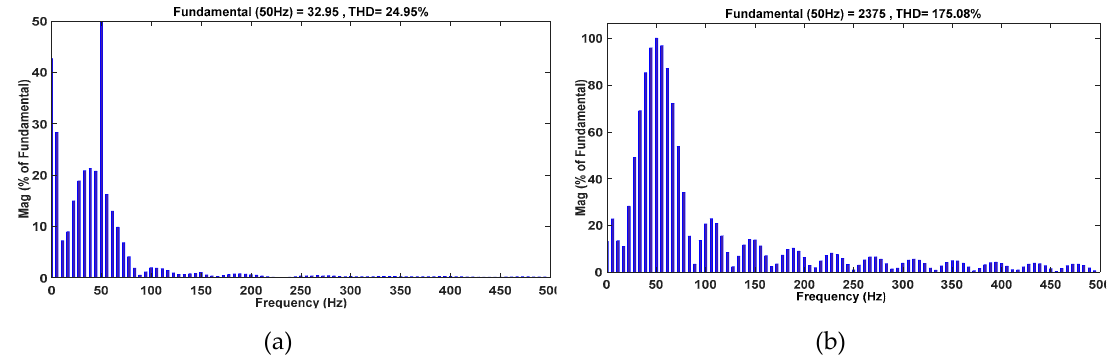
Figure 12. THD with PI controller for grid current ( a ) and voltage ( b ) during the P-G fault.